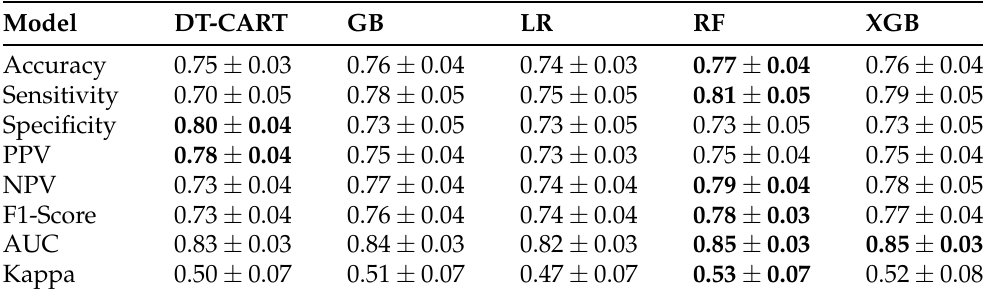
Table 5. Statistical summary of metrics in the training data set.